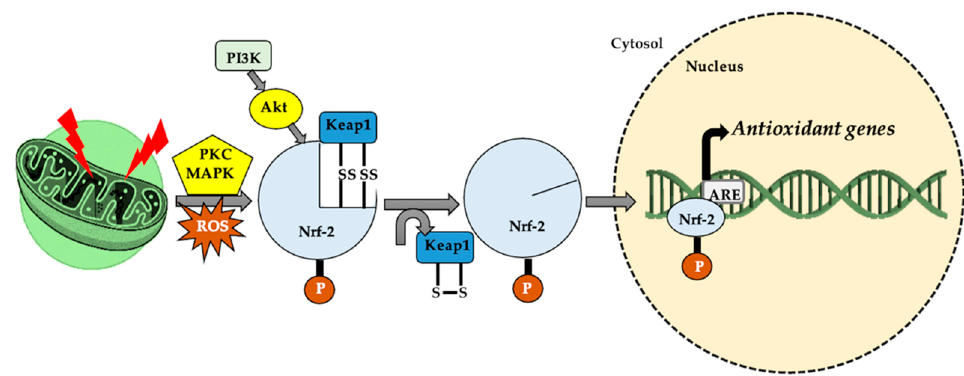
Figure 4. In cellular homeostasis, nuclear factor erythroid 2-related factor (Nrf-2) stabilizes by attaching to Keap-1 in the cytoplasm. The appearance of a stressor/reactive oxygen species (ROS) generator, under the action of protein kinase C (PKC), mitogen-activated protein kinase (MAPK) and phosphoinositide 3-kinase–protein kinase B (PI3K–Akt system), the thiol (-SH) groups belonging to Kelch-like ECH-associated protein 1 (Keap-1) are oxidized (S-S cross links). This leads to Nrf-2 dissociation and translocation in the nucleus, where it attaches to a specific sequence, antioxidant responsive element (ARE), thus increasing cellular antioxidant activity.